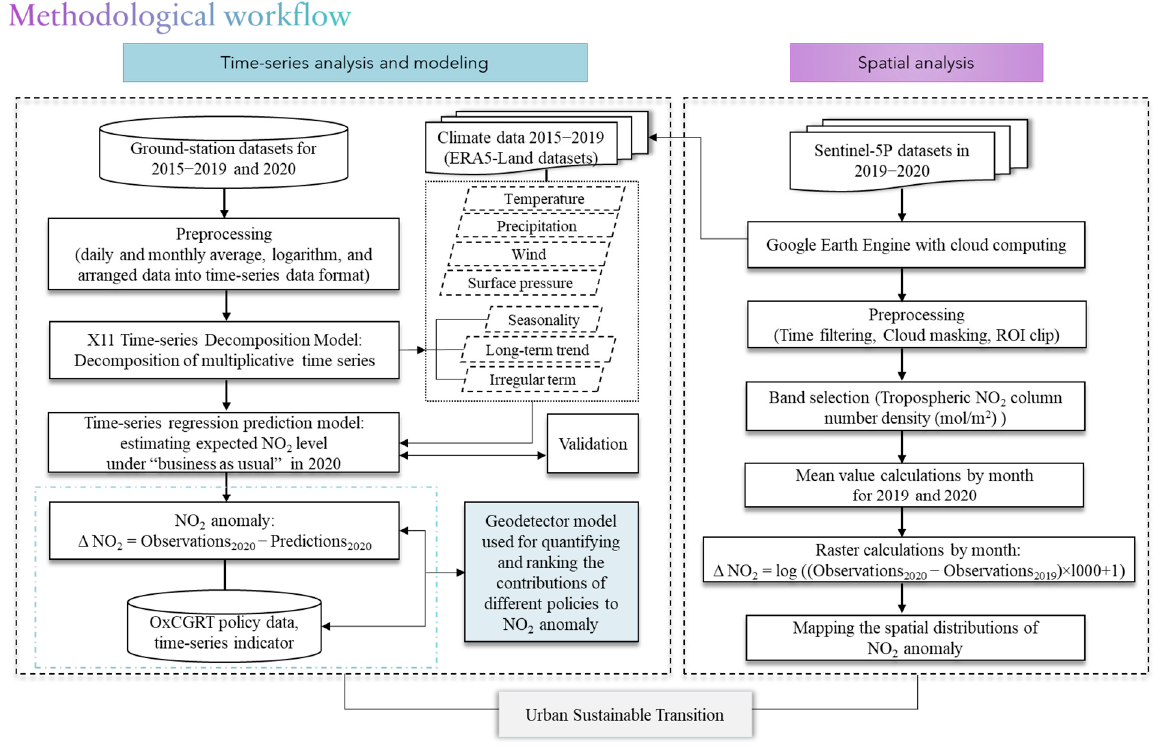
Figure 2. Overview of the methodological workflow.